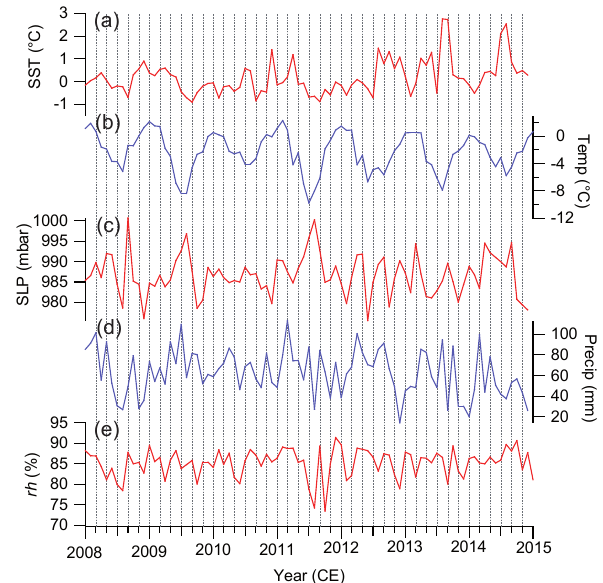
Figure 2. Monthly meteorological data sets used in this study (a) sea surface temperature (SST), (b) air temperature (Temp), (c) sea level pressure (SLP) and (d) precipitation amount (Pre- cip) from Bellingshausen Station (BE) on King George Island and (e) relative humidity (rh) from the Southern Ocean surrounding the northern Antarctic Peninsula (AP). Data shown in the figure is available from the READER dataset (https://legacy.bas.ac.uk/met/ READER/) (Turner et al.,